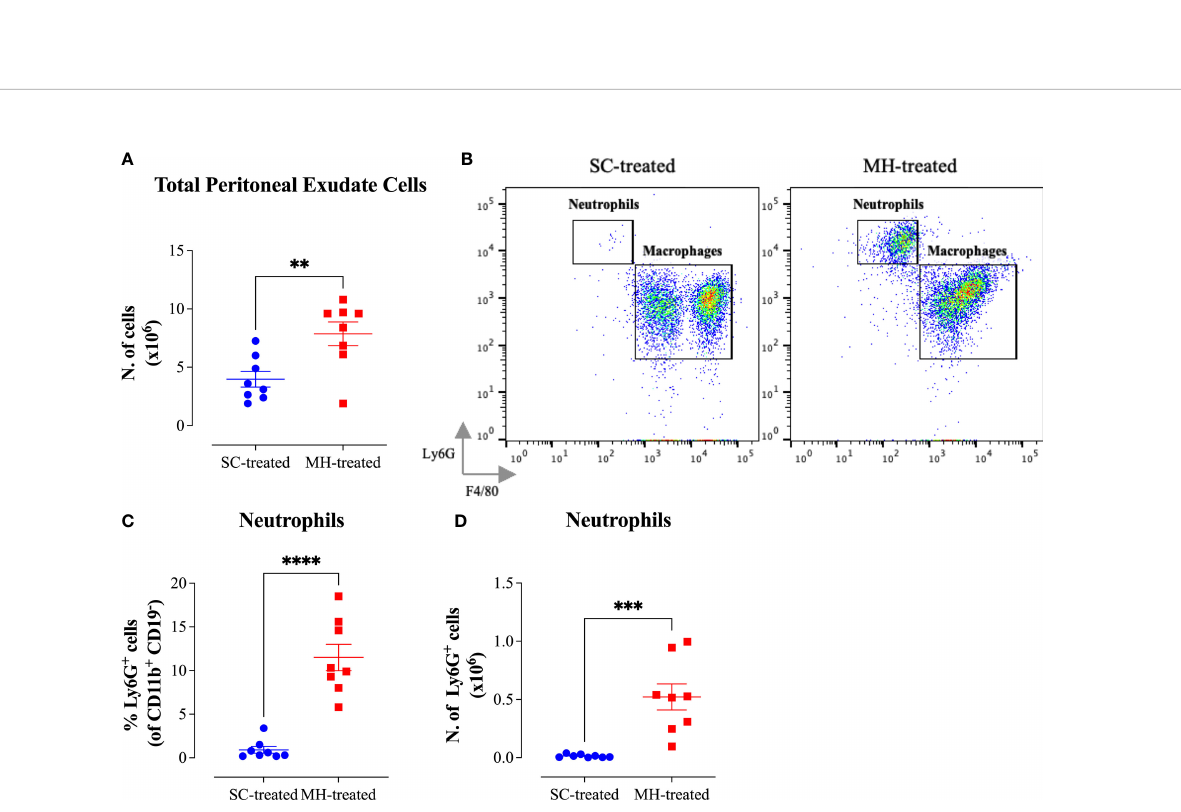
FIGURE 3 MH induces the recruitment of neutrophils into the peritoneal cavity of C57BL/6 mice. (A) Total number of PECs following treatment with SC or MH. (B) Representative dot plots showing Ly6G + neutrophils and F4/80 + macrophage subpopulations within the PECs (gated on CD11b + CD19 - CD11c - cells). (C, D) Quanti fi cation of the percentage (C) and absolute number (D) of neutrophils (Ly6G + cells) in the peritoneal cavity of C57BL/ 6 mice following treatment with SC or MH. Asterisks denote statistically signi fi cant differences between the MH-treated and SC-treated groups. The values for individual mice in a group (and mean ± SEM) are shown (SC-treated: n=8, MH-treated: n=8), pooled from 2 individual experiments. p values were calculated using the unpaired Student ’ s t-test (**p ≤ 0.01, *** p ≤ 0.001, **** p ≤